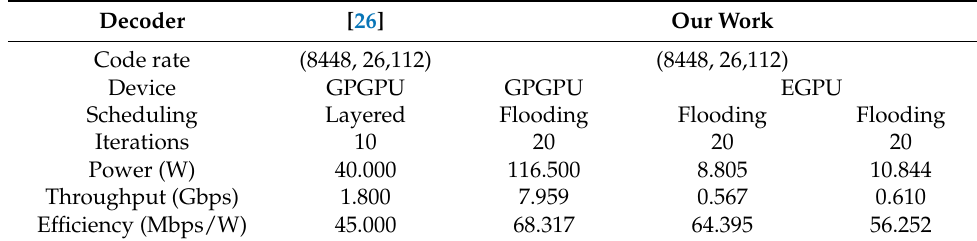
Table 2. Power efficiency performance comparison.